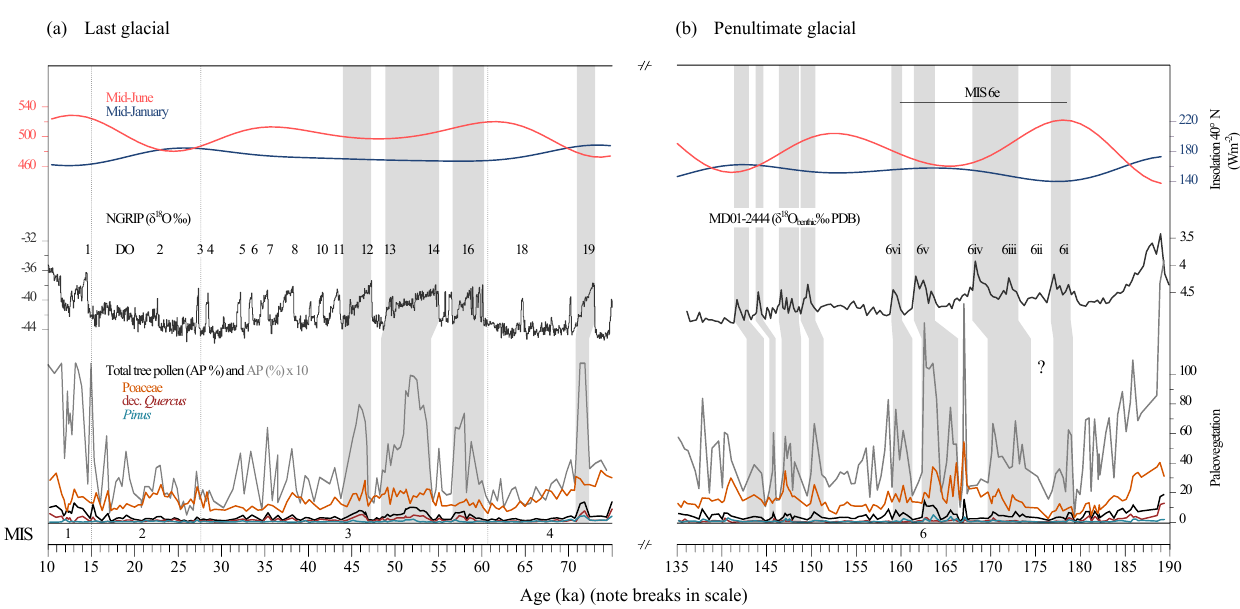
Figure 6. Comparison of the (a) last glacial period (MIS 4-2; Pickarski et al., 2015b) with the (b) penultimate glacial (this study) charac- teristics at Lake Van. Shown are the insolation values (40 ◦ N, Wm − 2 ) after Berger (1978) and Berger et al. (2007), the δ 18 O profile from the NGRIP ice core (Greenland; NGRIP members, 2004) labeled with Dansgaard–Oeschger (DO) events 1 to 19 for the last glacial period, the δ 18 O composition of benthic foraminifera of the marine core MD01-2444 (Portuguese margin; Margari et al., 2010) for the penultimate glacial, and the Lake Van paleovegetation with AP % (shown in black), AP in 10-fold exaggeration (gray line), Poaceae, deciduous Quercus , and Pinus . The gray boxes mark the comparison between the different paleoenvironmental records of pronounced interstadial oscillations. Marine isotope stage (MIS; Lisiecki and Raymo, 2004) and informally numbered interstadials of the MD01-2444 record are indicated (Mar- gari et al.,